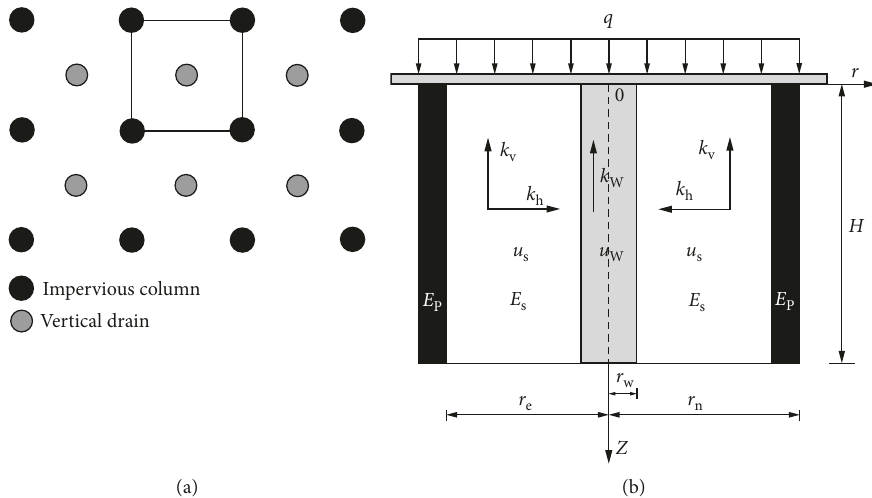
Figure 1: Vertical drain-impervious column multicomposite foundation consolidation model. (a) Layout plan. (b) Cutaway